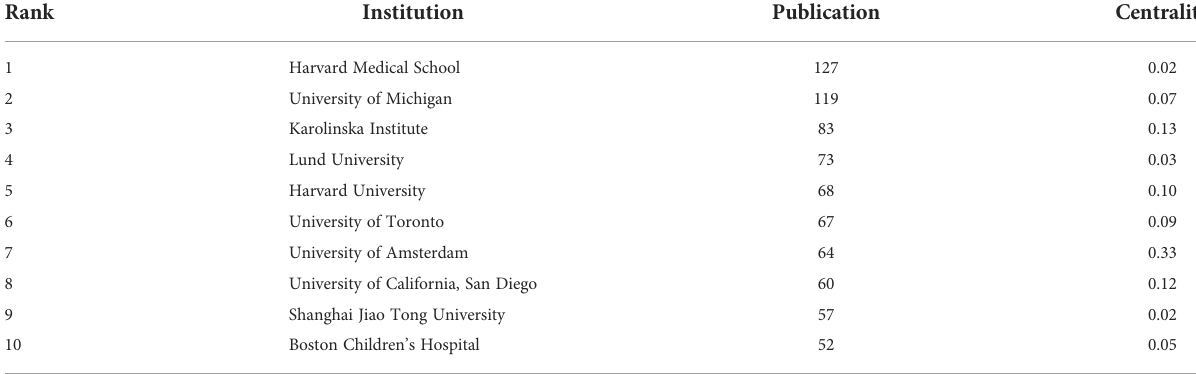
TABLE 2 Top 10 institutions in terms of number of articles issued and the corresponding centrality.